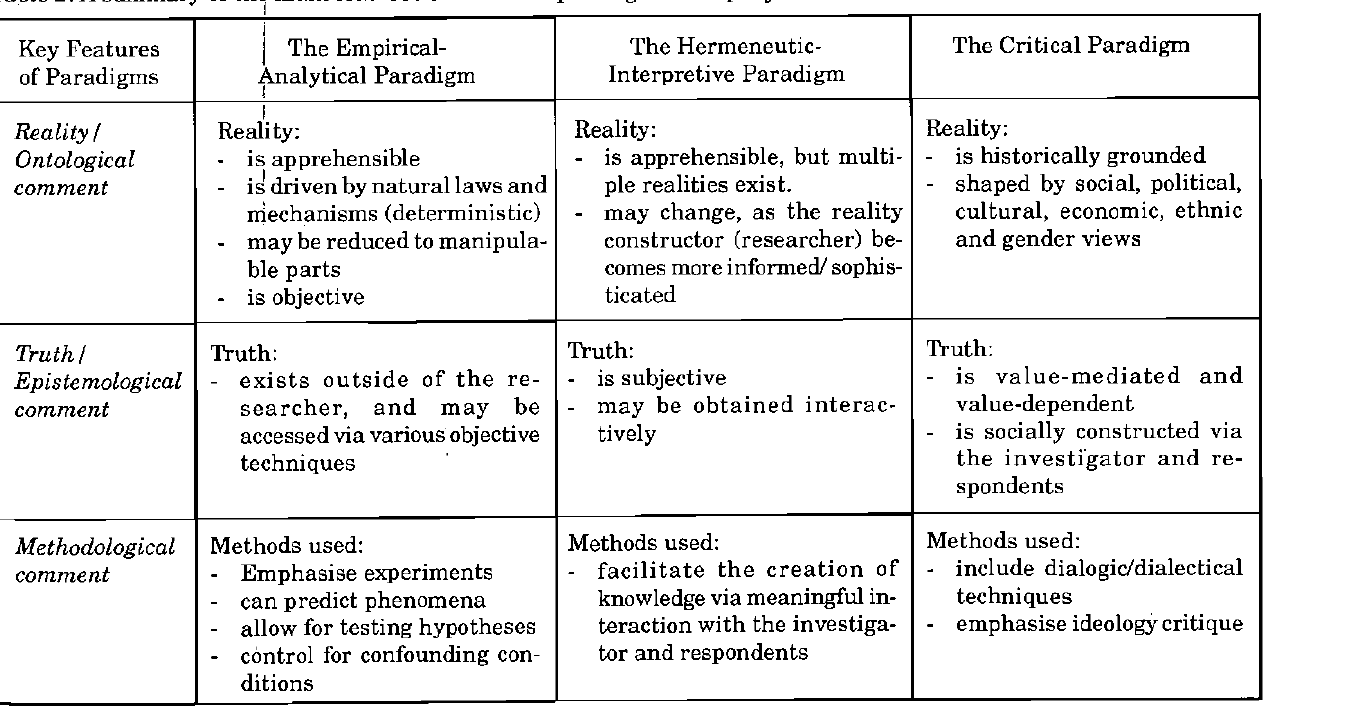
Table 2: A summary of the main features of the three paradigms of